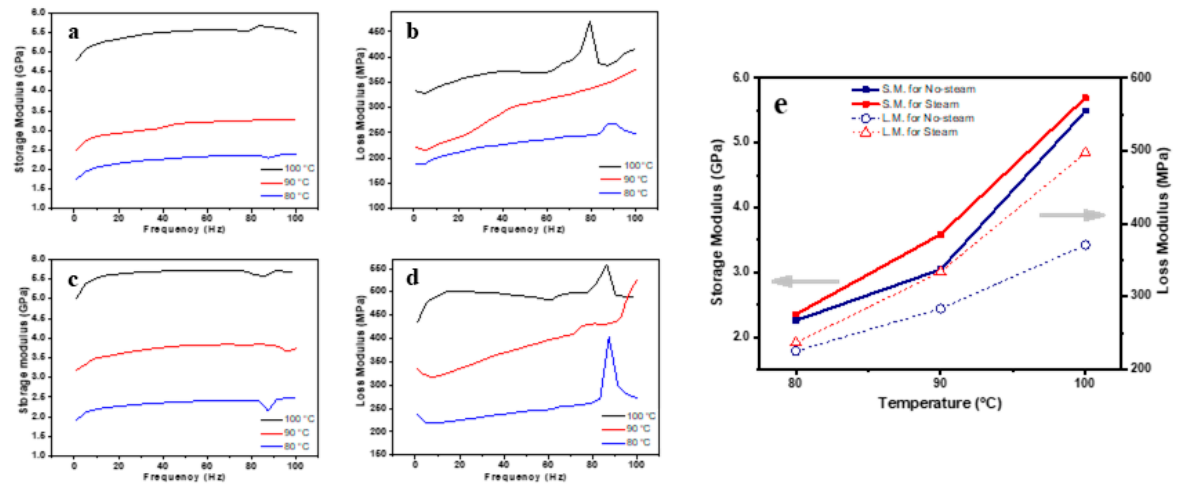
Figure 3. ( a ) Frequency-dependent storage modulus and ( b ) loss modulus for the no-steam processed bulk materials; ( c ) storage modulus and ( d ) loss modulus for the steam processed bulk materials fabricated at 80, 90, and 100 ℃ ; ( e ) recap of storage and loss moduli with temperatures at 38 Hz.